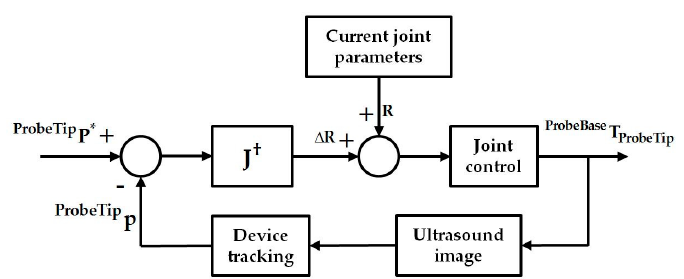
Figure 4. Jacobian position control loop for localized adjustment of the probe to monitor the catheter. In the diagram, J † is the pseudo-inverse of the final Jacobian J .